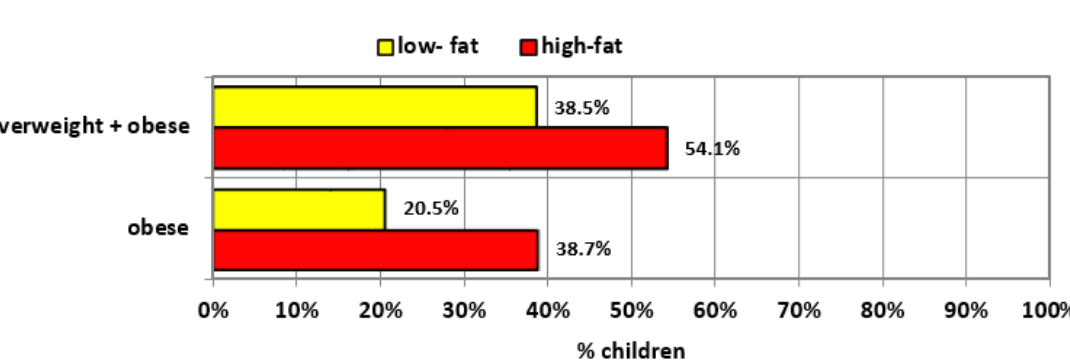
Figure 2. Preferences of the fat taste (character) among mothers and the occurrence of overweight and obesity among children.